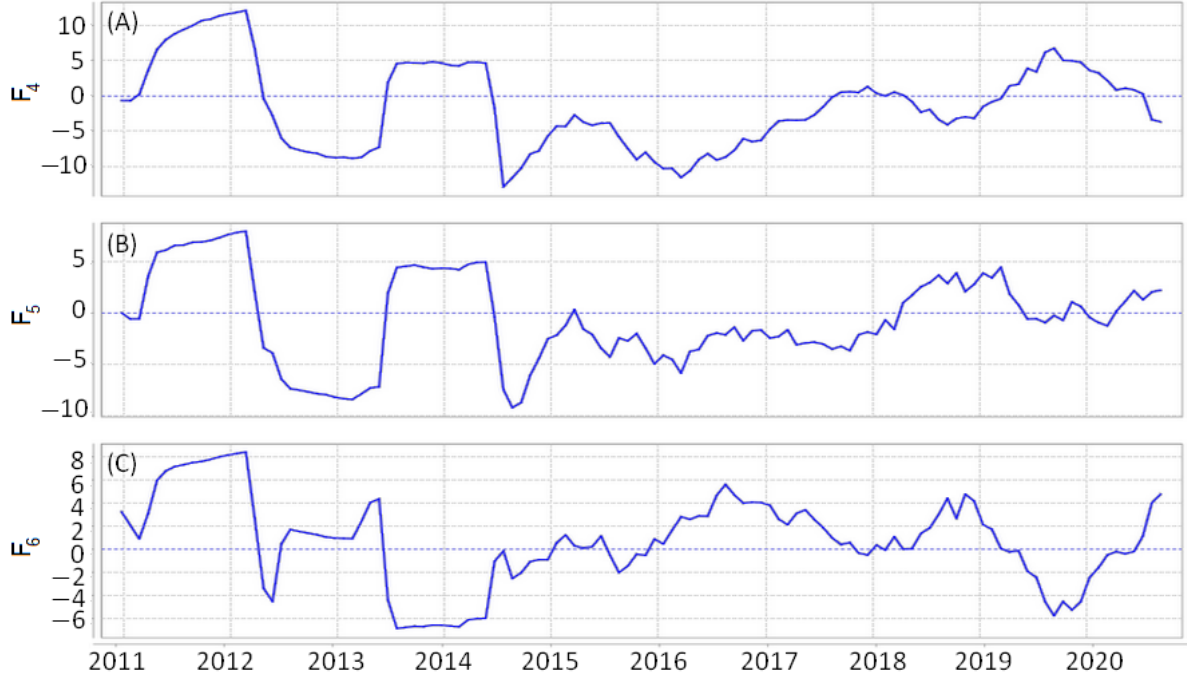
Figure 10. Japan. Time series at point 35.45 ◦ N and 139.2 ◦ E. ( A ) Field F 4 ; ( B ) field F 5 ; ( C ) field F 6 .